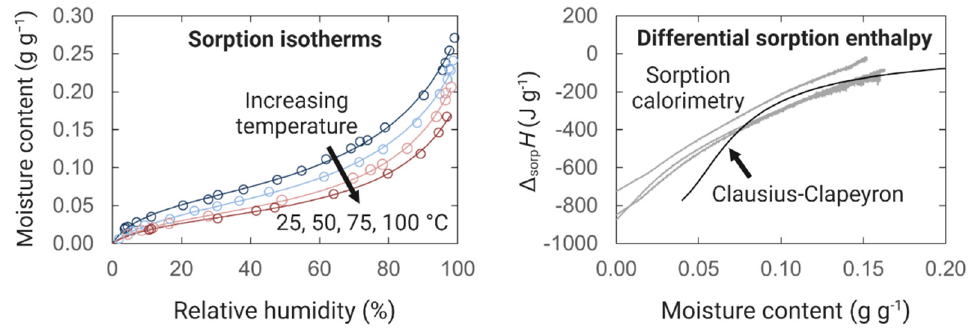
Figure 3. Differential sorption enthalpy ( right ) derived from the Clausius-Clapeyron equation on sorption isotherm data ( left ) after fitting the ABC isotherm (Equation (4), Section 3.3) [85]. Additionally shown is differential sorption enthalpy determined directly from sorption calorimetry. Sorption isotherm data for spruce [86] and sorption calorimetric data for Scots pine [84].